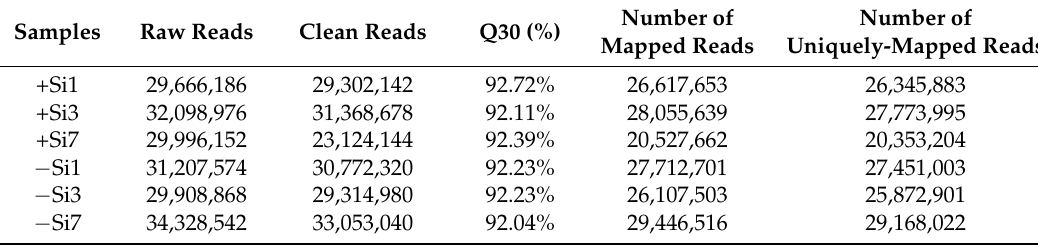
Table 1. Summary of RNA-Seq and mapping results.